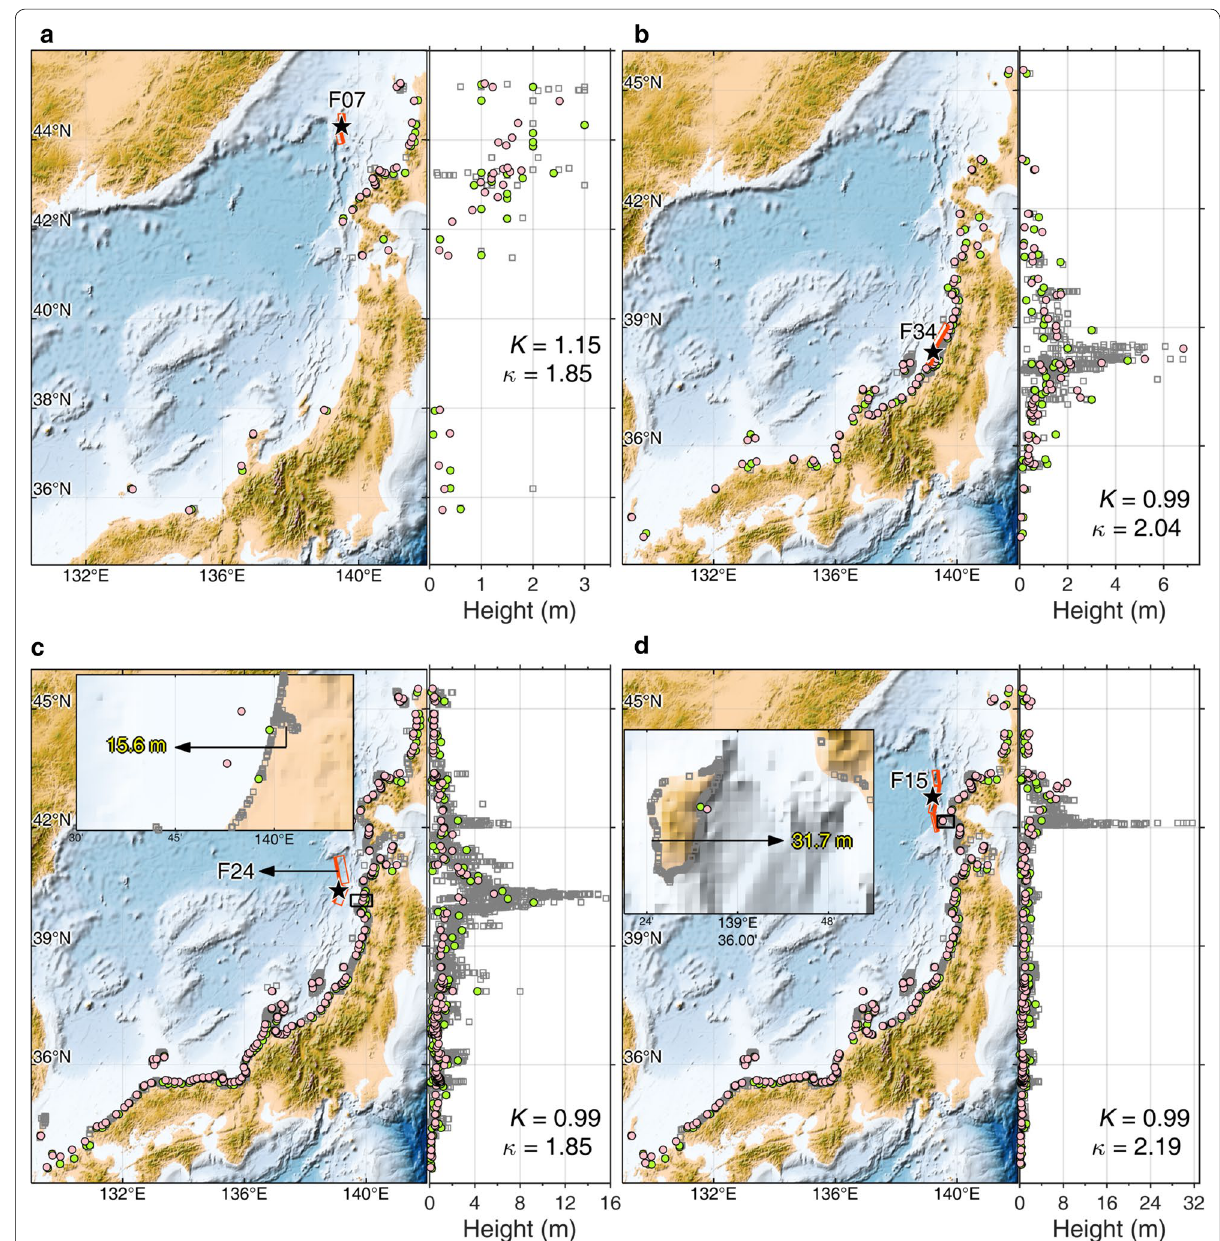
Fig. 4 Comparison of simulated versus measured coastal tsunami heights of four historical events: ( a ) 1940, ( b ) 1964, ( c ) 1983, and ( d ) 1993 near the locations of interest. Gray squares on the maps indicate observation points with the nearest points to the locations of interest (pink dots) marked using green dots. The corresponding coastal tsunami heights are color-coded in the respective right panel. The associated faults are annotated, and earthquake epicenters are shown by black stars. Insets in c , d indicate the locations of the highest measured tsunamis. The K and κ are calculated from the measured heights and the simulated heights after applying the Green’s